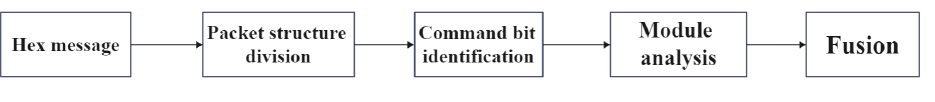
Figure 6. Analysis of the